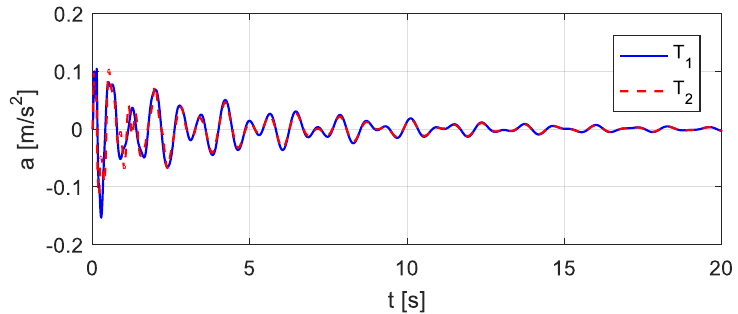
Figure 24. Estimated accelerations in case wheel T 2 bumps.